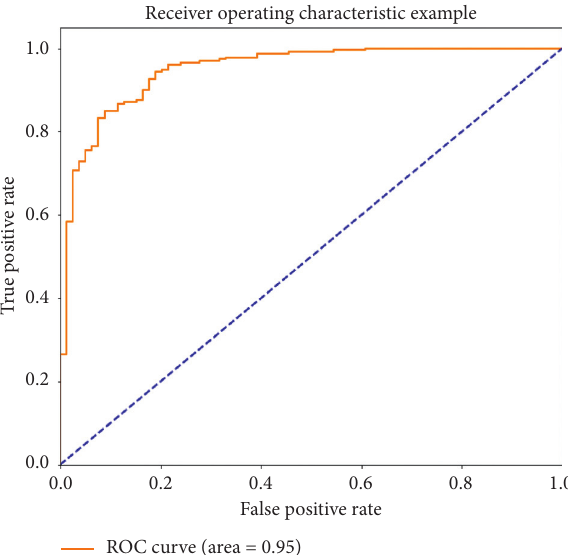
Figure 1: ROC curve of the XGBoost model after